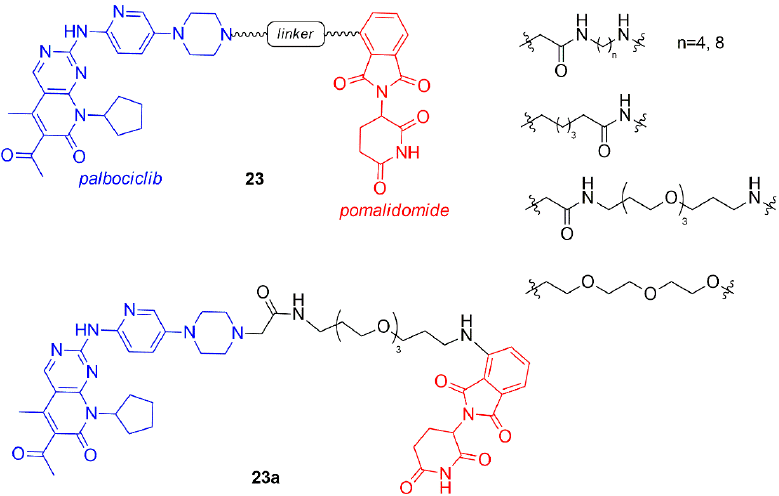
Figure 14. Chemical structures of palbociclib/pomalidomide PROTACs.